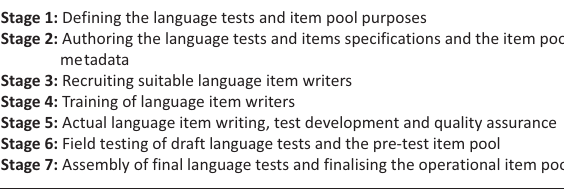
FIGURE 1: The language tests and language item pool development process.